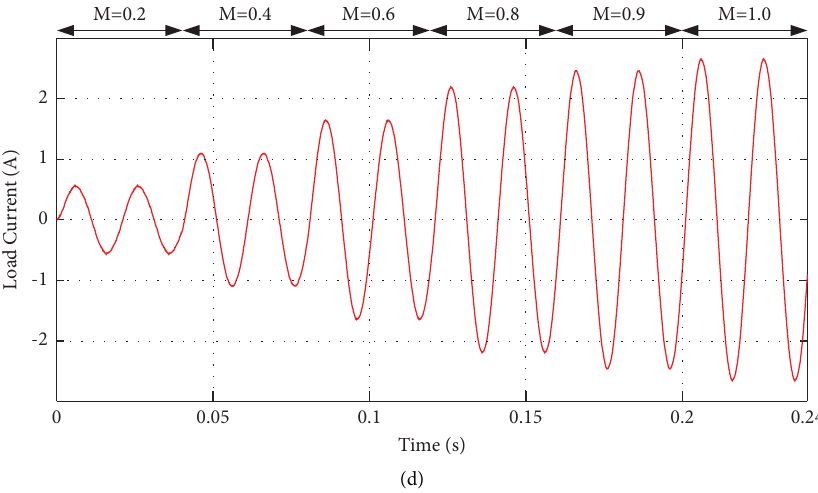
Figure 11: 11L CHB inverter load current for dynamic values of M . (a) SPWM. (b) THIPWM. (c) SVPWM-I. (d)